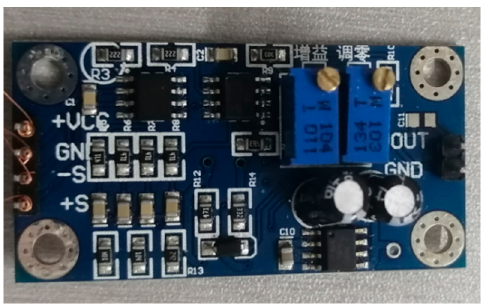
Figure 14. Circuit design of the flexible thermocouple film sensor.